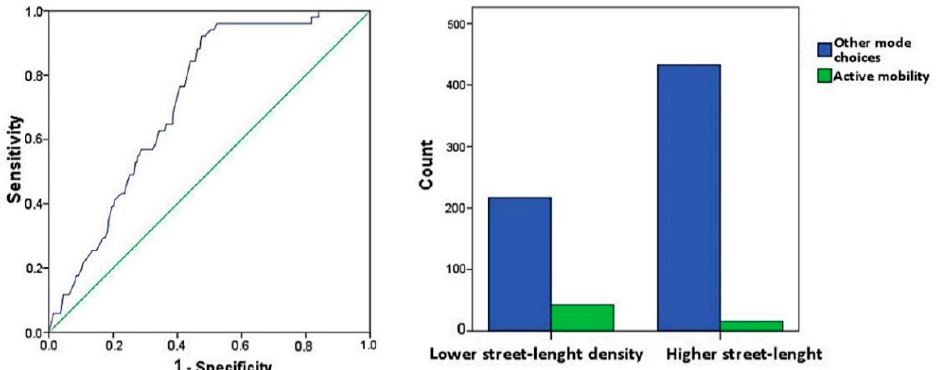
Figure 6. Curve analysis for street-length density around workplaces and the use of active mobility modes for commuting. Table 4. Chi-square test for mode